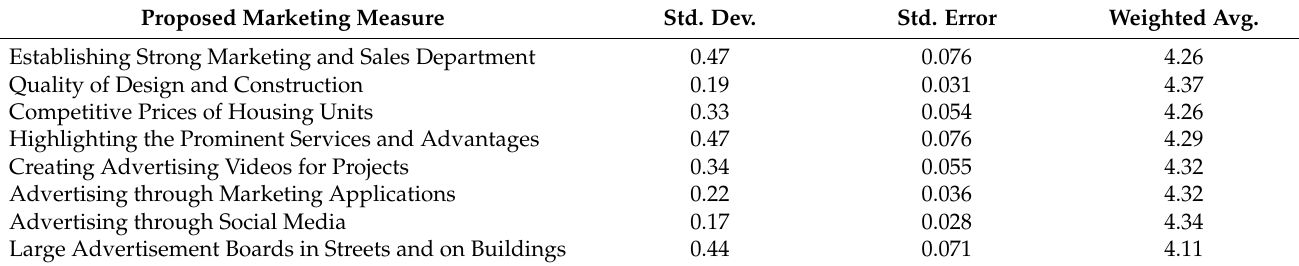
Table 3. The Weighted Average of Proposed Financial Measures Opted by